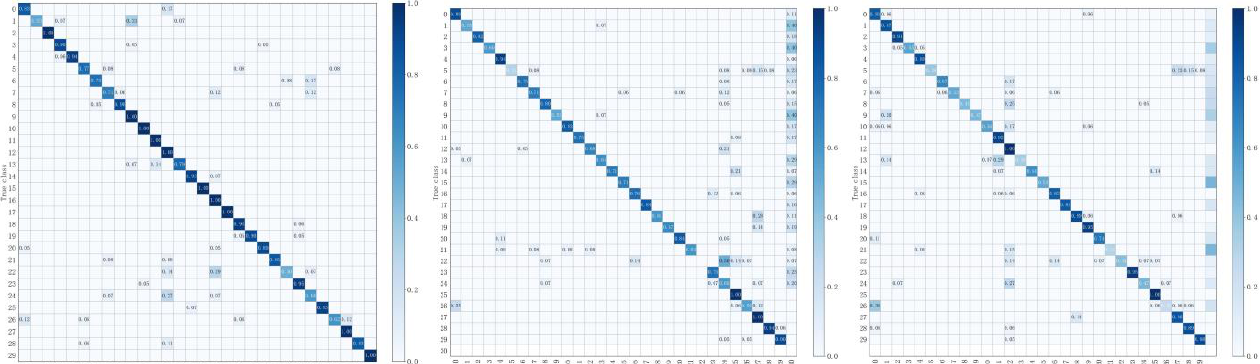
Figure 7. From left to right, the confusion matrix for each of the three steps on the AID dataset.